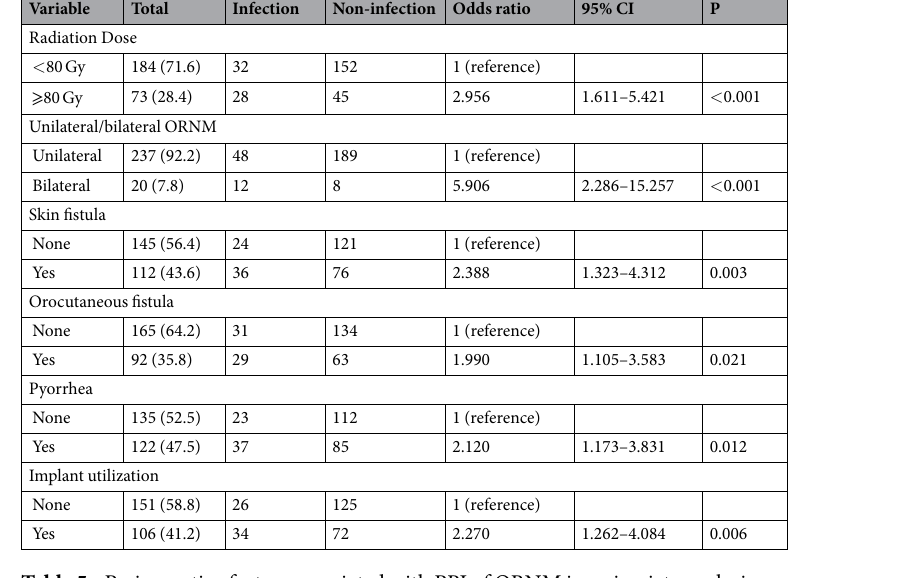
Table 5. Perioperative factors associated with PPI of ORNM in univariate